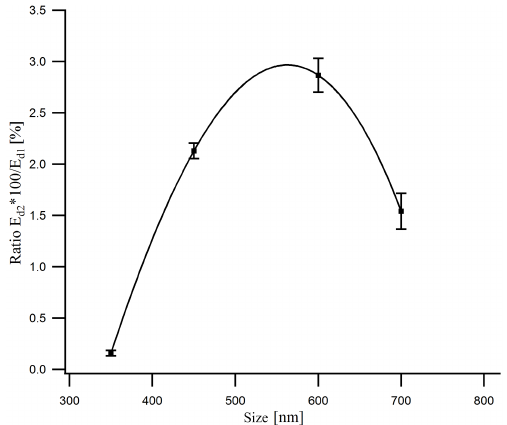
Figure 8. The ratio E d2 /E d1 (%) as a function of the PSL particle